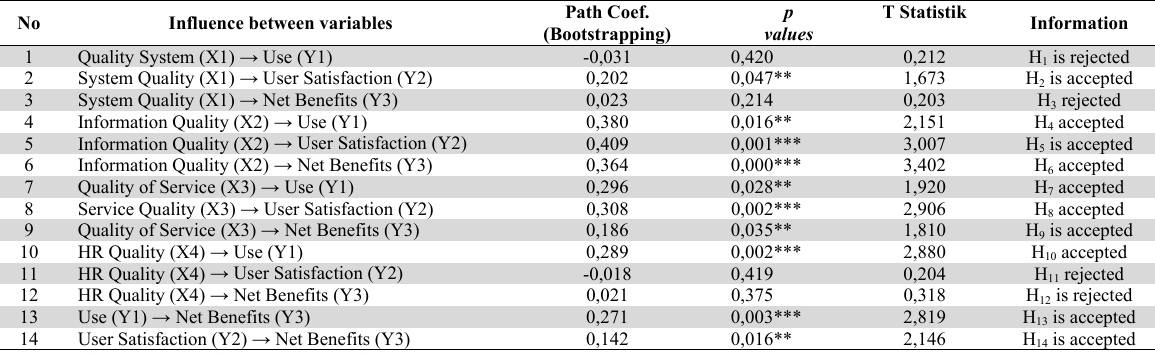
Direct Effects Testing